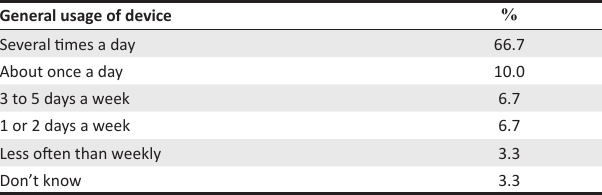
TABLE 5: Frequency of primary wireless device usage irrespective the type of activity ( N = 30). General usage of device